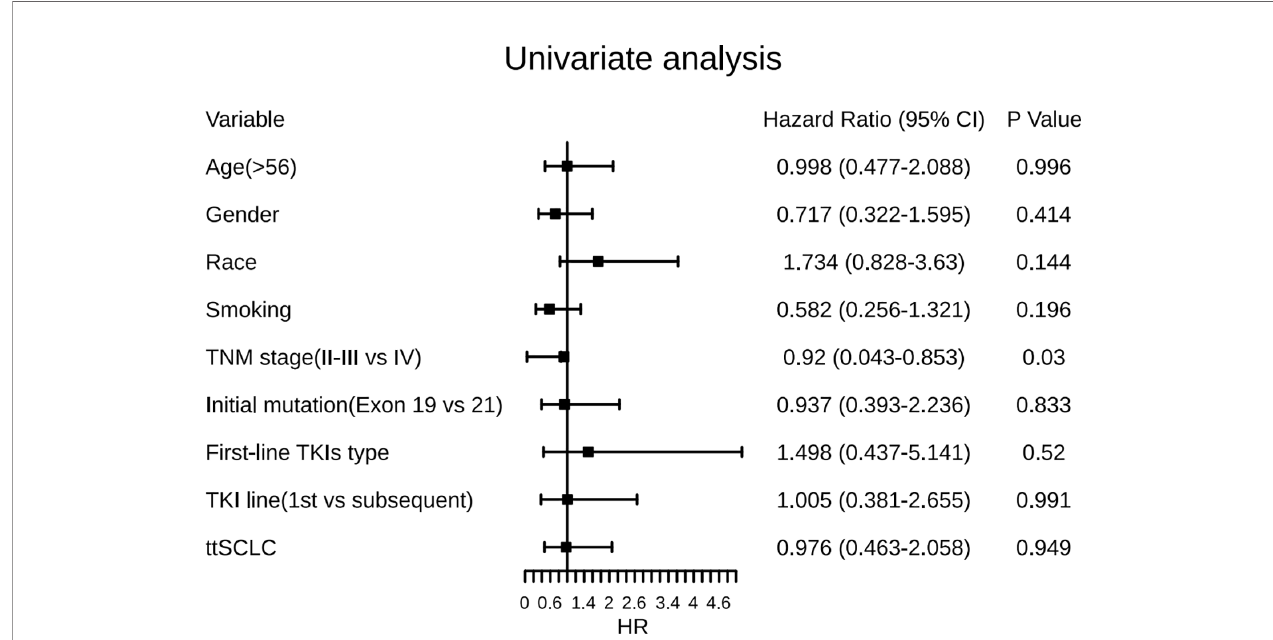
FIGURE 10 | Forest plots of the effect of several factors on OS after development of SCLC phenotype. ttSCLC, the time to small cell lung cancer transformation; TKIs, Tyrosine kinase inhibitors; Exon 19, EGFR Exon 19-deletion; Exon 21, EGFR Exon 21-L858R; OS, overall